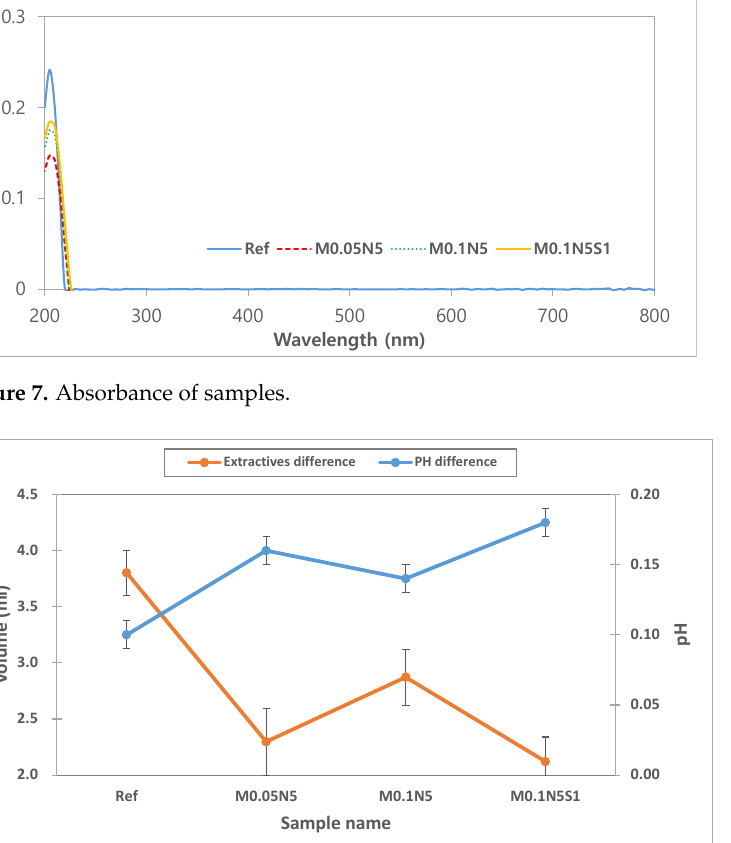
Figure 8. pH and extractables test of samples.